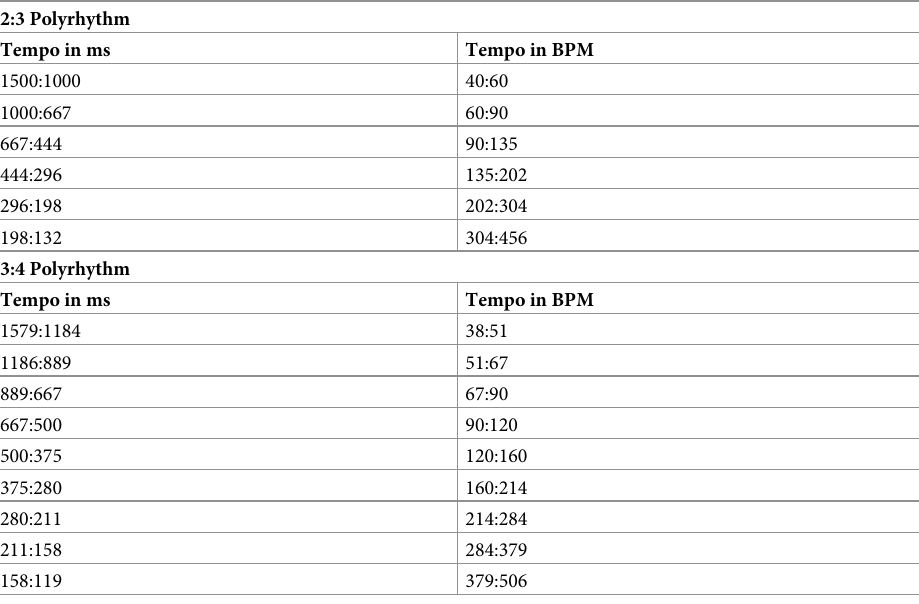
Table 1. The 15 stimuli of the tempo